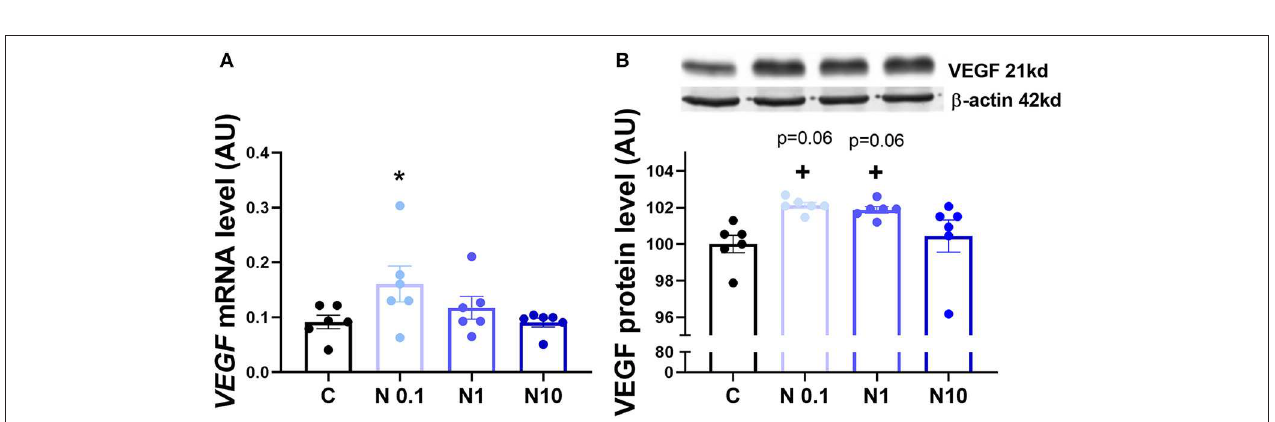
FIGURE 4 | VEGFA mRNA and protein expression after in vitro culture of mid CL explants. Expression of (A) vascular endothelial growth factor A (VEGFA) mRNA, (B) VEGFA protein after 24h culture: (i) no factor (C, negative control); (ii) Nodal (0.1ng/mL); (iii) Nodal (1ng/mL); (iv) Nodal (10ng/mL) ( n = 6). mRNA expression determined by real-time PCR, expression relative to β -2-microglobulin (B2MG) expression. Protein expression determined by western blot, upper panel: representative immunoblot; lower panel: densitometry of protein expression relative to β -actin expression. Values are expressed as means ± SEM in arbitrary units (AU). Statistical differences are marked with asterisks (* p <